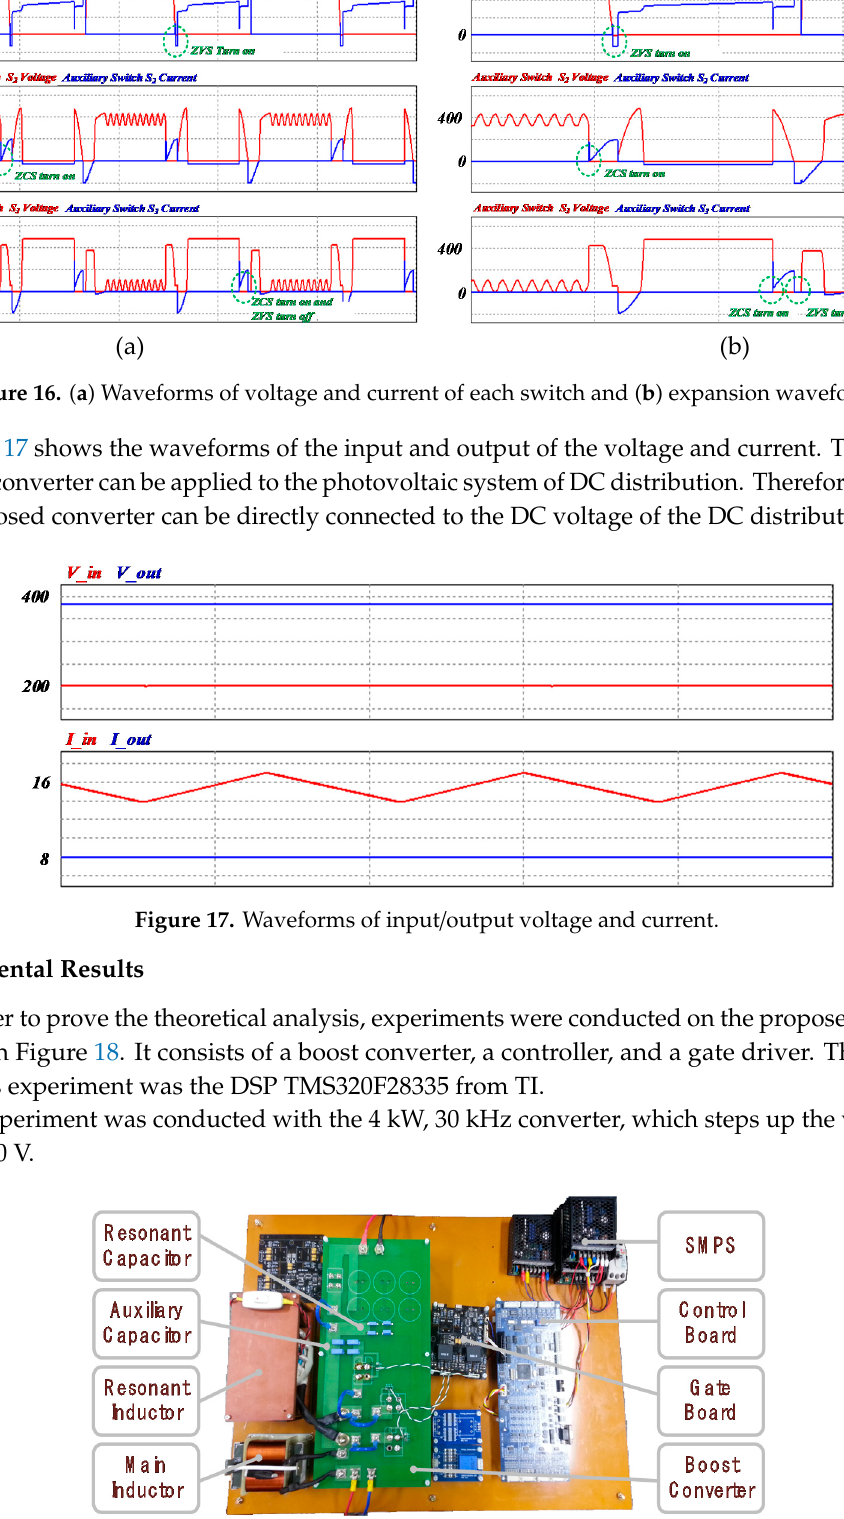
Figure 15. Waveforms of PWM signal and resonant inductor current. ( a ) Conventional converter and ( b ) proposed converter.